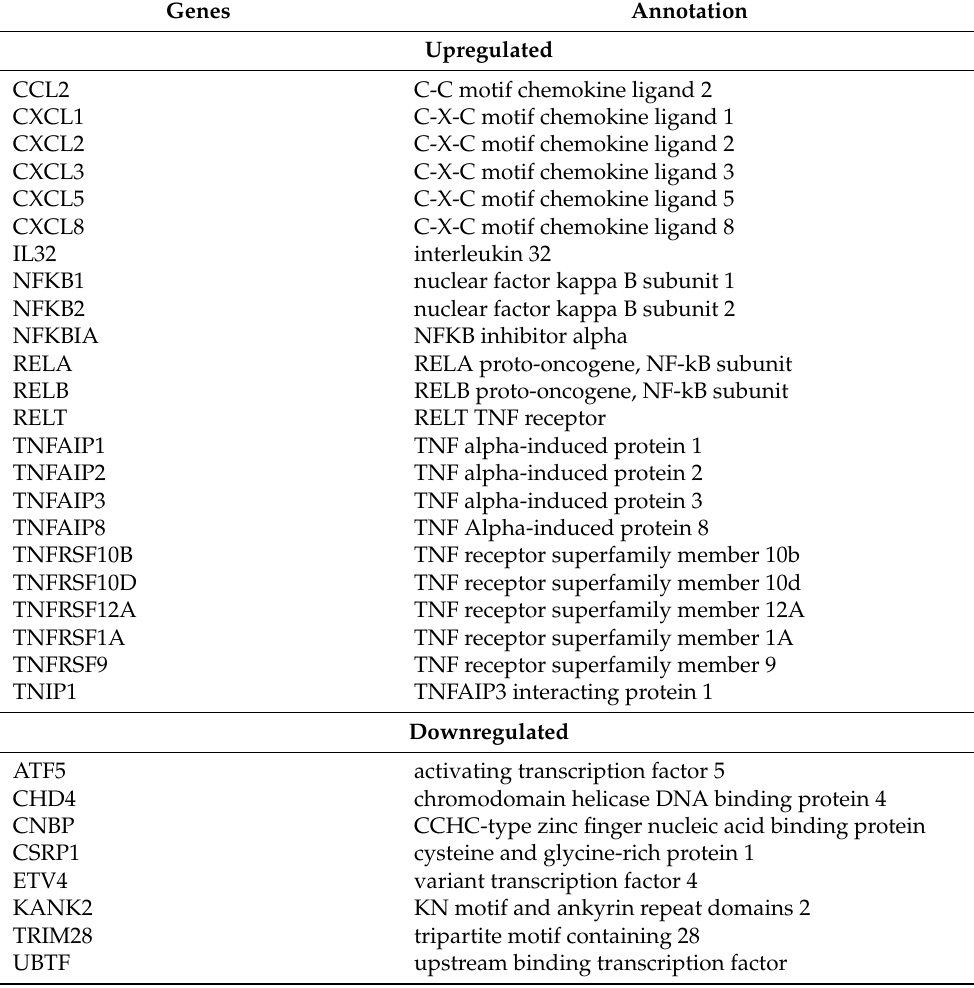
Table 4. Representatives of genes whose mRNA levels were differentially expressed after 6 h as well as after 12 and 24 h of incubation of A549 cells with